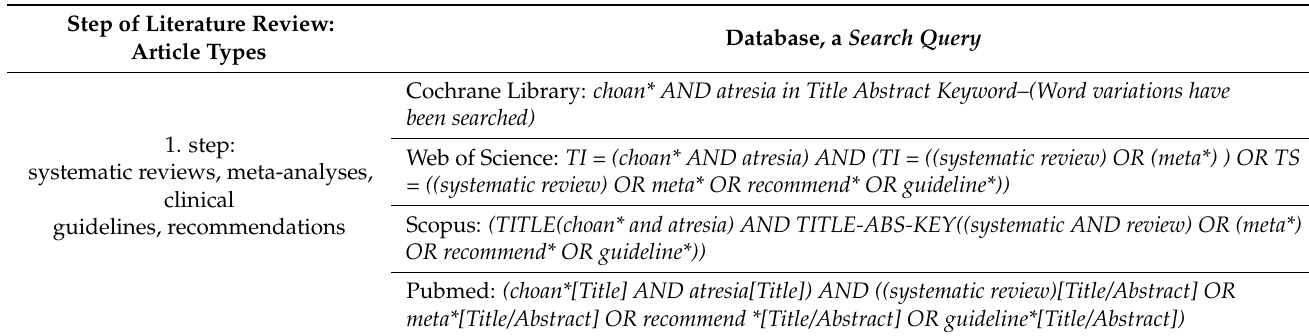
Table 3. Three-step process of reviewing the supporting literature in preparing Slovenian recommen- dations for the treatment of choanal